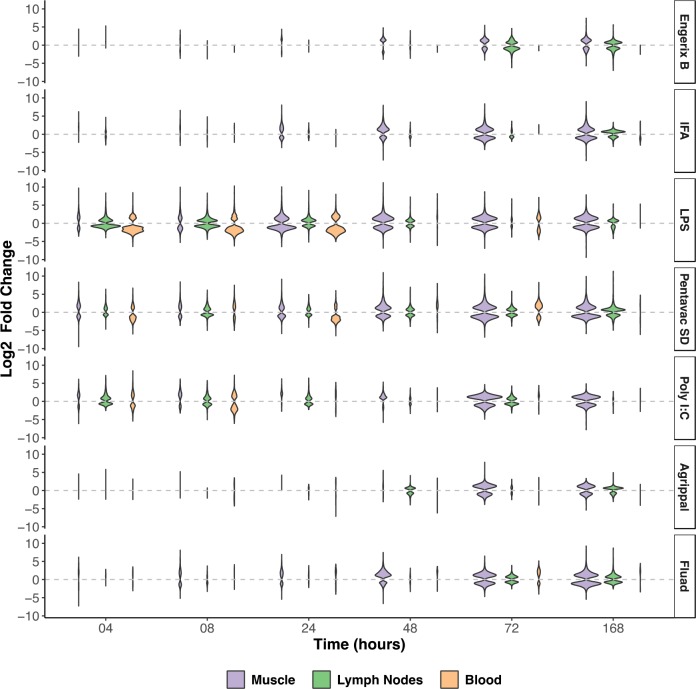
Overview of the transcriptomic responses to the injected vaccines and TLR agonists in the injected muscle, the draining lymph nodes (MLN), and the blood.The width of each violin is scaled to the number of genes that are differentially expressed at each given time point (BH-adjusted p-value <0.01). Differentially expressed genes were defined as those with a significant (BH-adjusted p-value <0.01) change in expression in a vaccinated group, when compared to the unvaccinated group and the saline group at a given time point. The upregulated or downregulated differentially expressed genes (Log2 fold-change) are presented for each tissue sampled and at each timepoint after injection of the vaccine or TLR agonist (n = 5 mice per timepoint). The vaccines or TLR agonists that were used are indicated on the right of the figure. IFA, incomplete Freunds adjuvant; LPS, lipopolysaccharide.